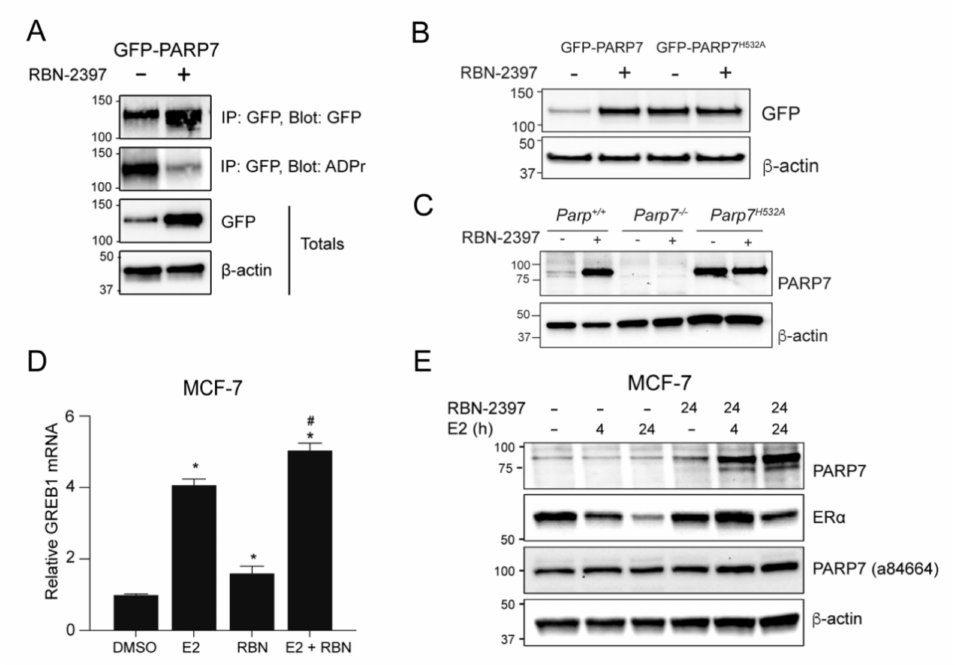
Figure 2. Inhibition of PARP7 activity stabilizes PARP7 protein levels and increases ER α activity. ( A ) RBN-2397 stabilizes PARP7 protein levels and decreases catalytic activity. COS-1 cells were transfected with GFP-PARP7 and treated with 0.1% DMSO or 100 nM RBN-2397 for 24 h. Samples were immunoprecipitated with anti-GFP, and membranes were blotted with anti-GFP and anti-ADP-ribose antibodies. ( B ) COS-1 cells were transfected with GFP-PARP7 or GFP-PARP7 H532A and treated with 0.1% DMSO or 100 nM RBN-2397 for 24 h. ( C ) Parp7 +/+ , Parp7 − / − or Parp7 H532A MEFs were treated with 0.1% DMSO or 100 nM RBN-2397 for 24 h. The membrane was probed with our lab generated anti-PARP7. ( D ) Treatment with RBN-2397 increases mRNA expression of ER α target gene GREB1. Wildtype MCF-7 cells were treated with 0.1% DMSO, 10 nM E2 or co-treated with E2 and 100 nM RBN-2397 for 24 h. The asterisk * denotes significant differences ( p < 0.05) from DMSO, and the hash mark # denotes significant differences ( p < 0.05) compared to E2 treatment alone. ( E ) E2 stimulation increases PARP7 protein expression. MCF-7 cells were treated with 10 nM E2 for 0, 4 and 24 h, together with control (no treatment) or 24 h treatment with 100 nM RBN-2397. The membrane was blotted with our lab generated anti-PARP7, anti-ER α , or anti-PARP7 (Abcam; ab84664) antibodies. PARP7 bands are visible in samples co-treated with E2 and RBN-2397. Anti-PARP7 (ab84664), did not detect endogenous PARP7, but rather detected a protein at approximately 100 kDa in all